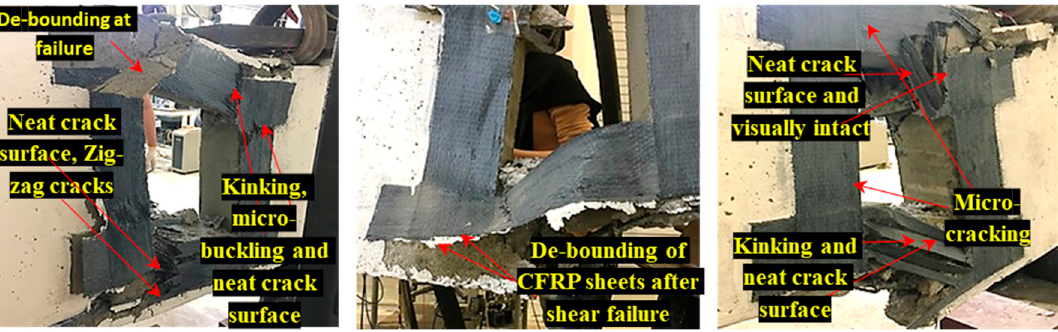
Figure 15. Typical post-mortem photos after the static four-point bending tests of the deep beams with opening.